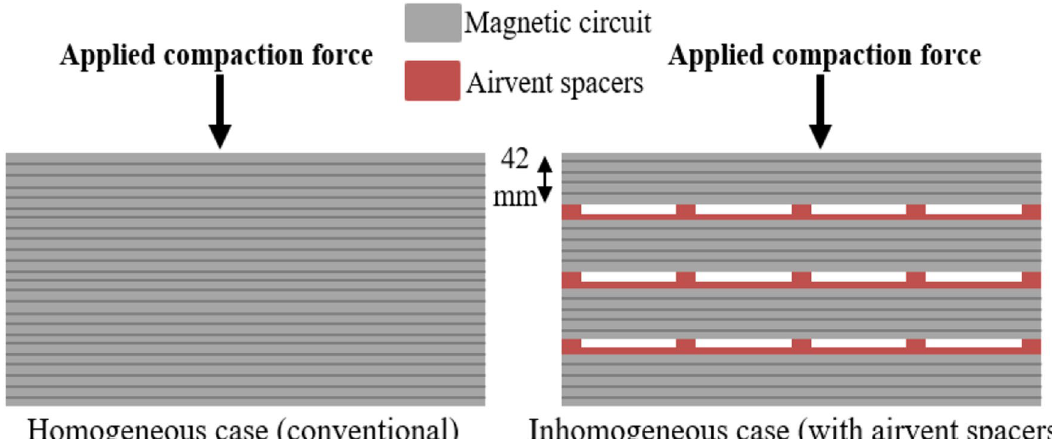
Figure 1. The two studied configurations.